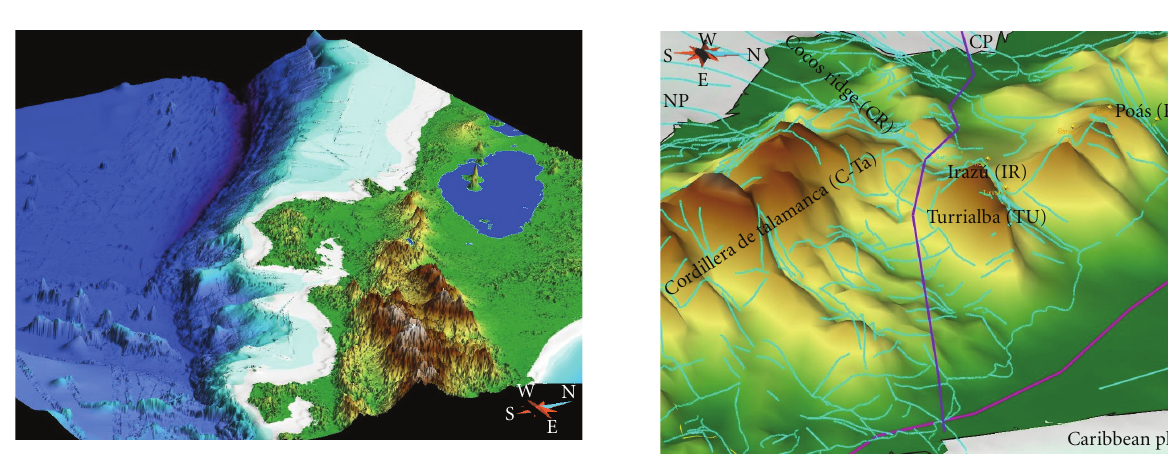
Figure 7: A perspective view from east along one of Costa Rica’s main fault system. It separates the active volcanoes (east of the dark purple fault line) from the inactive volcanic Talamanca belt in the south of Costa Rica. The lineament continues to the southern tip of Nicoya Peninsula and strikes the Cocos Ridge. To visualize these lineaments, we have chosen lower-resolution topography from 3 × 3km ETOPO2v2 data